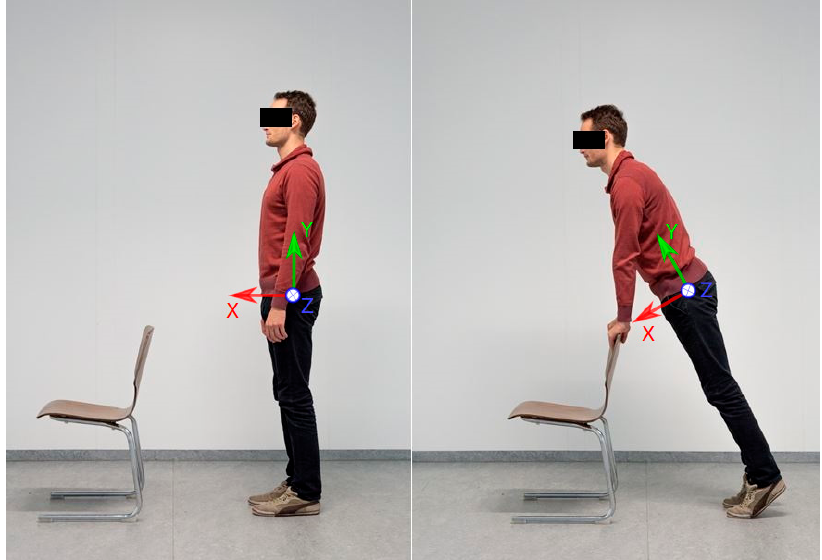
Figure 2. Demonstration of the two-step-calibration process. On the left side the subject is standing in neutral zero position. On the right side, the subject is slightly inclined forward, so that every lower body segment is rotated only around the 𝑧 -axis shown in the figure (frontal body axis).